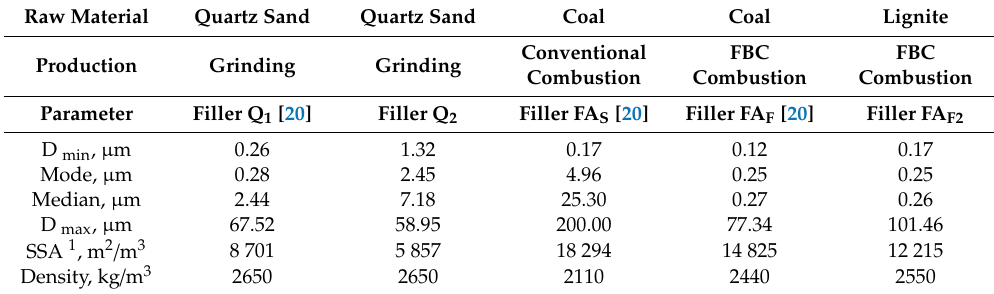
Figure 4. Particle size distribution plots and SEM micrographs (magnification: 6000 × ) of the considered fillers (Q 1 , Q 2 , quartz powders; FA S , siliceous fly ash; FA F , fluidized fly ash from hard coal combustion; FA F2 , fluidized fly ash from lignite combustion). Table 1. Statistical parameters describing the particle size distribution and specific surface area (SSA) of fillers; Q 1 , Q 2 , quartz powders; FA S , siliceous fly ash; FA F , FA F2 , fluidized fly